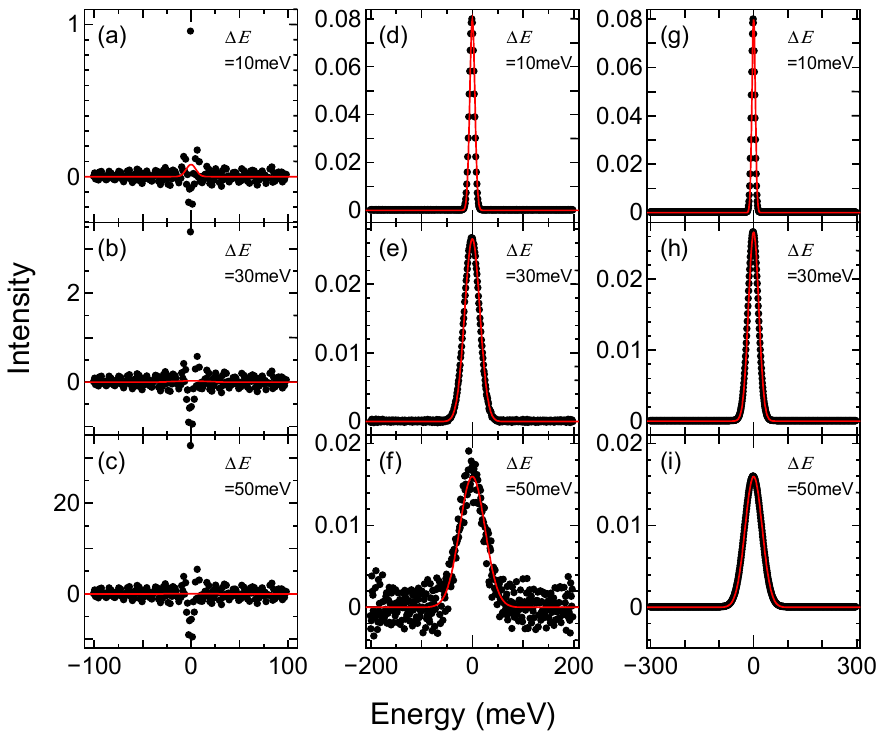
Figure 2. The broadening functions derived from FDG function of T = 100 K (black dots) and the convoluted original Gaussian functions (red lines). The spectrum widths W sp and the broadening widths of the original Gaussian functions Δ E ( a ) W sp = 200 meV, Δ E = 10 meV, ( b ) W sp = 200 meV, Δ E = 30 meV, ( c ) W sp = 200 meV, Δ E = 50 meV, ( d ) W sp = 400 meV, Δ E = 10 meV, ( e ) W sp = 400 meV, Δ E = 30 meV, ( f ) W sp = 400 meV, Δ E = 50 meV, ( g ) W sp = 600 meV, Δ E = 10 meV, ( h ) W sp = 600 meV, Δ E = 30 meV, ( i ) W sp = 600 meV, Δ E = 50 meV.